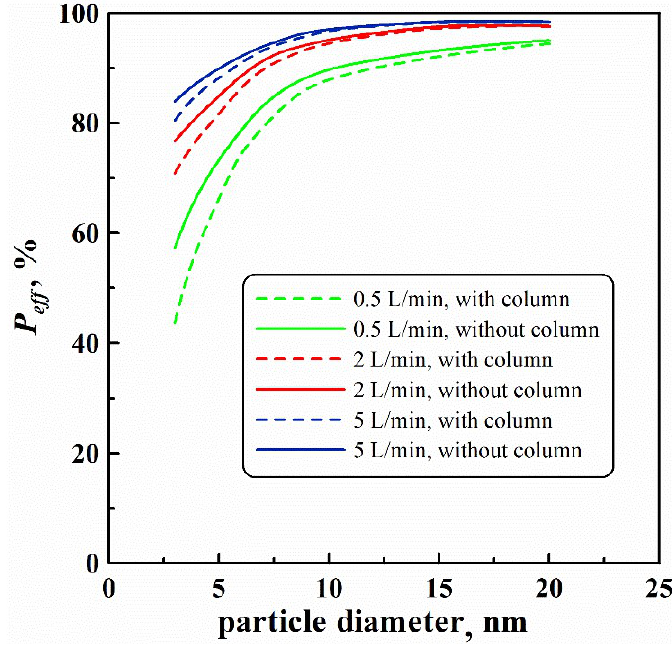
Figure 9. Nanoparticle penetration efficiency of the hollow tapered cylinder with or without the conical column at different flow rates.